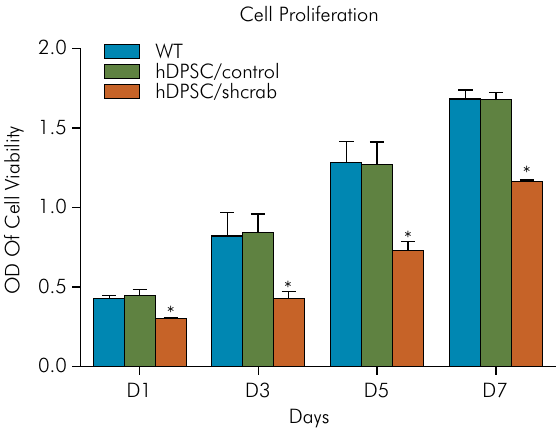
Figure 4. CRABP2 promotes the proliferation of hDPSCs. The CCK-8 assay indicated that the cell viability of the hDPSC/ shcrab group was significantly lower compared with the hDPSC/control and wt groups (P<0.05) on days 1, 3, 5, and 7. Data represent the mean ± SD of at least 3 independent